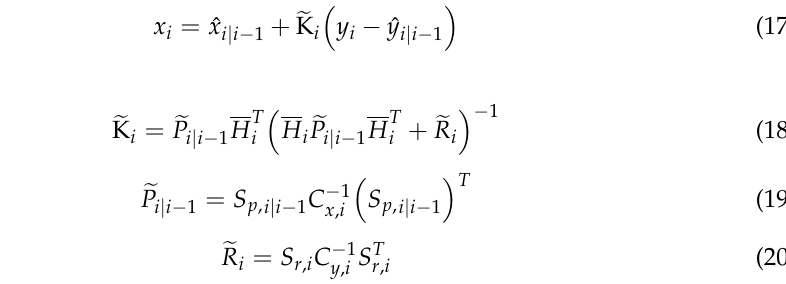
... Figure 3. Temporal and spatial correlation of distribution network measurement data. The active daily load curve of FTU measurement for 30 days is obtained from the field measured data, as shown in Figure 4. The change trend of the measured data changes periodically in time. The time series shows that the observation points after a time interval are similar, and the daily load curves of adjacent days are similar. At the same time, net ‐ work topology constraints and power flow constraints are found between various nodes of the power grid [24]. In addition, as shown in the schematic topology diagram of the power flow in Figure 5, the measurement data have a spatial correlation. Therefore, this study introduces the variable center cross ‐ correlation entropy function into the unscented Kalman filter algorithm and performs filtering and cleaning based on the spatiotemporal correlation of the measurement data, which allows for significant improvements in the